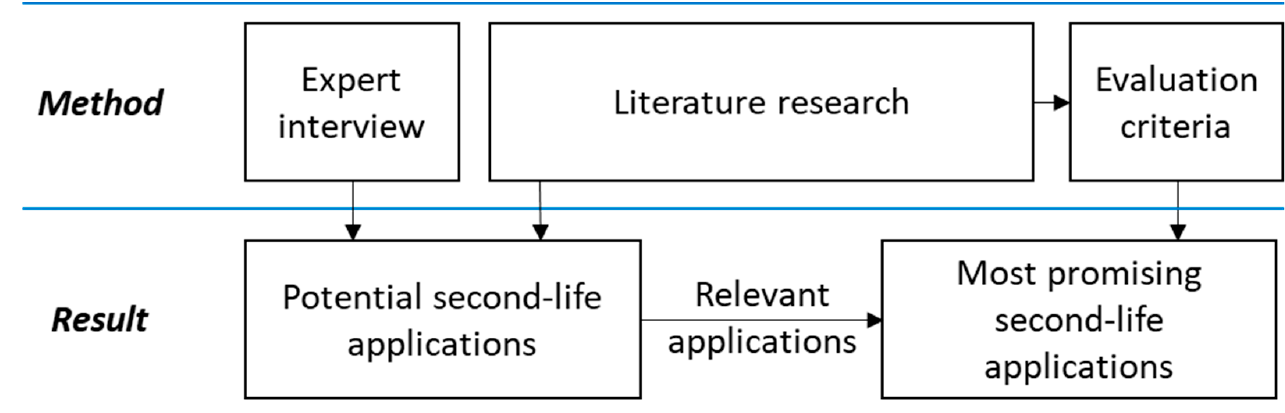
Figure 1. Schematic research workflow.